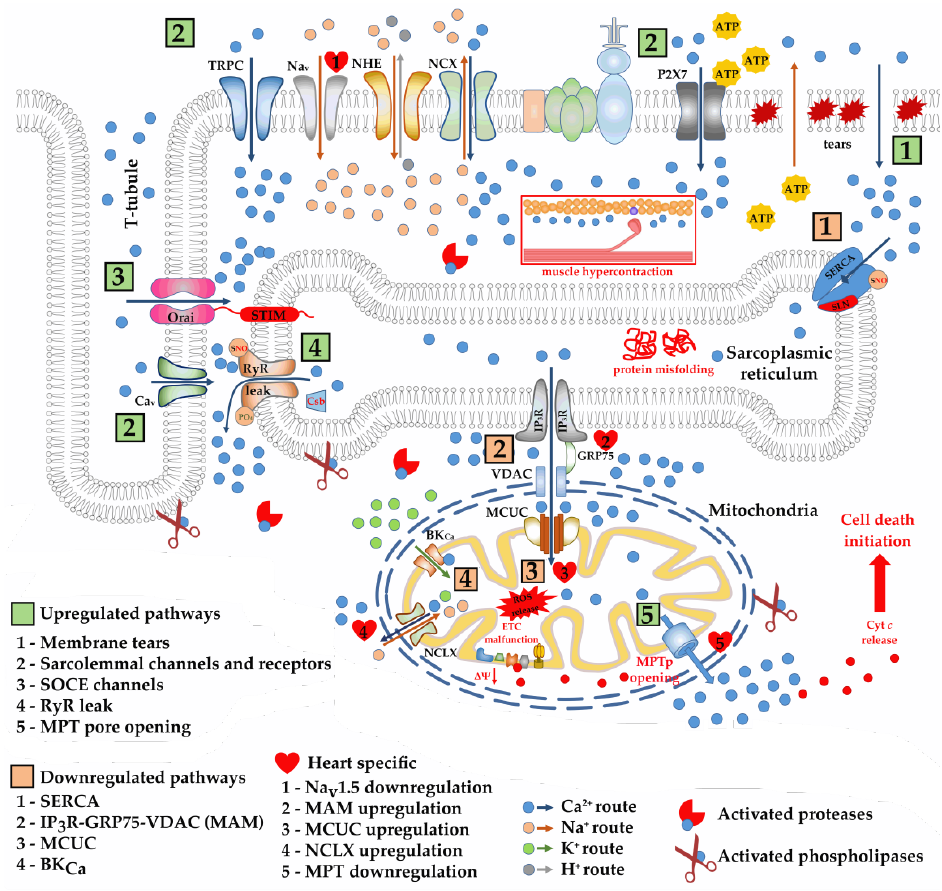
Figure 2. Schematic representation of the features of the functioning of the ion transport pathways of the sarcolemma, sarcoplasmic reticulum, and mitochondria in dystrophin-deficient striated muscle and the consequences of these changes. The picture shows upregulated and downregulated pathways. Specific changes identified in the heart in the early stages of DMD are also highlighted.